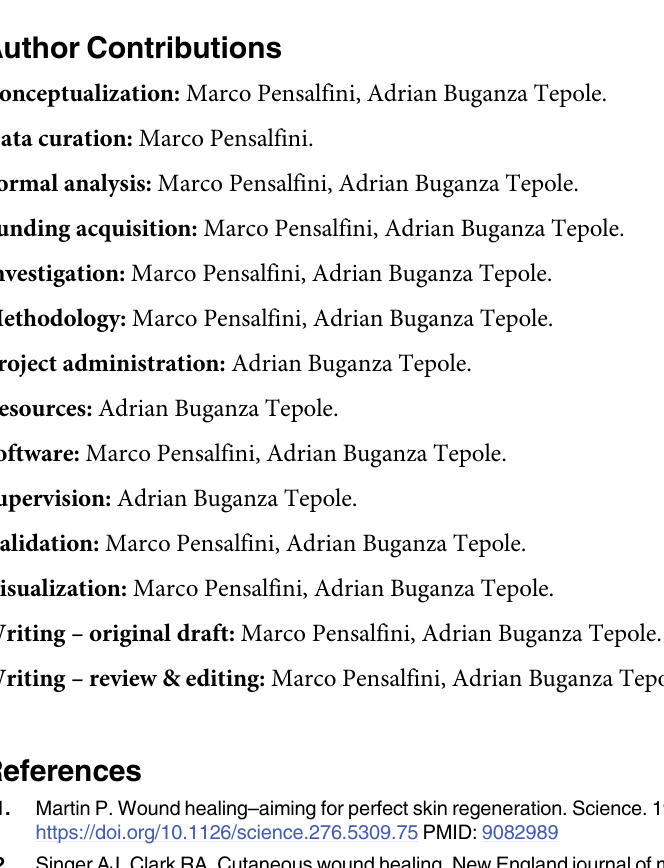
S1 Table. Search ranges for Bayesian model parameters. S2 Table. Global simulation parameters. S3 Table. Parameters for diffusible biochemical fields. S4 Table. Parameters for microstructural fields. S5 Table. Emergent constitutive biomechanical parameters (Eqs (2, 16 and